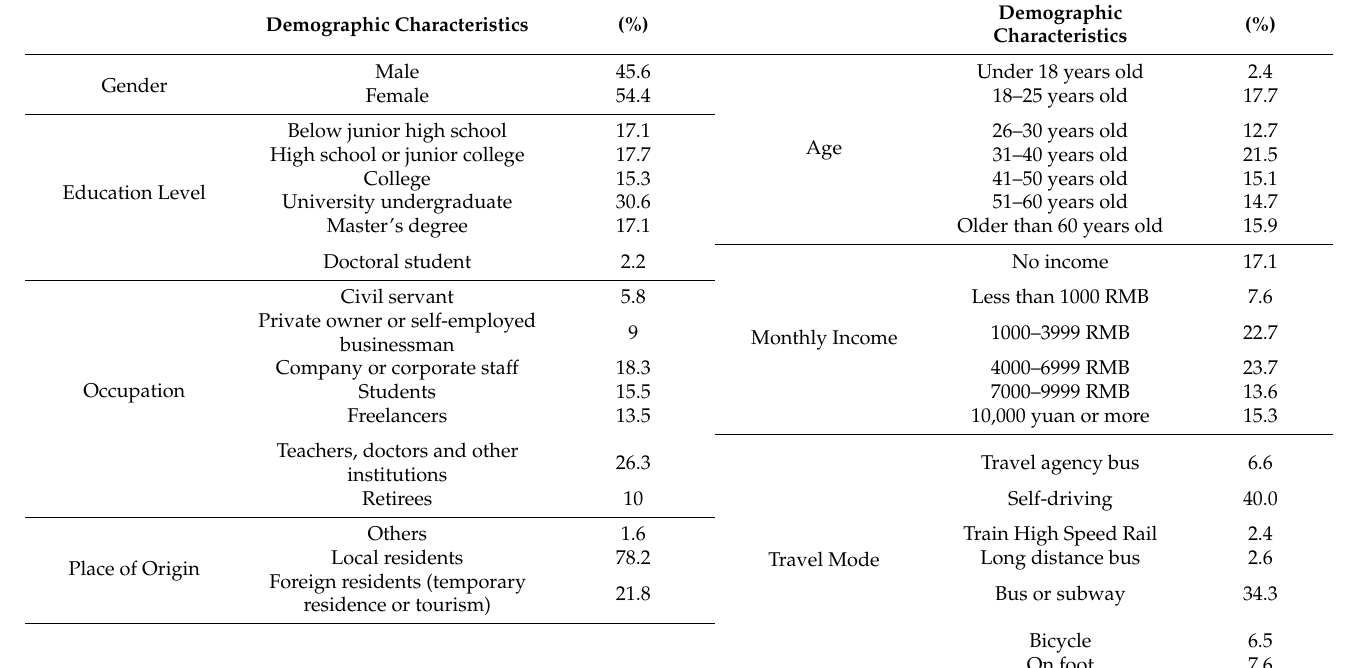
Table 2. Demographic